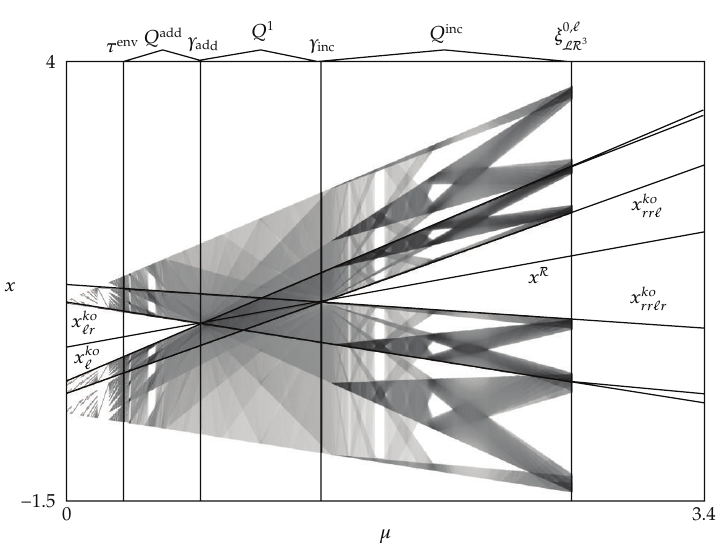
Figure 5: Numerically calculated bifurcation diagram for a (cid:6) 0 . 42, b (cid:6) − 1 . 37, μ (cid:6) 0 ··· 3 . 4, showing a typical part of the chaotic domain. The location of this scenario in the (cid:7) b,μ (cid:8) -plane is marked with B in Figure 2 (cid:7) c (cid:8) .